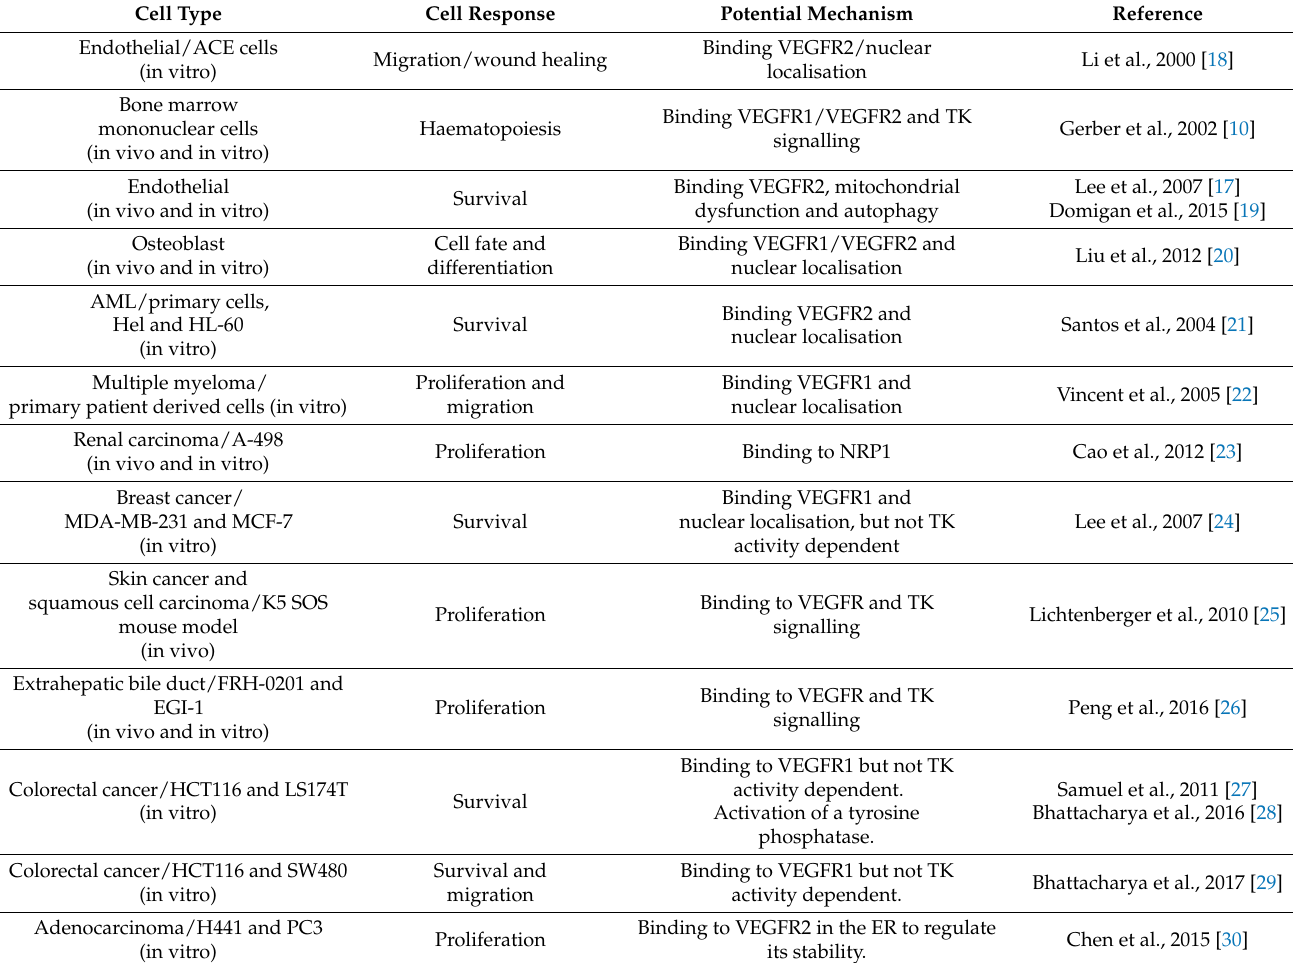
Figure 1. Different modes of Vascular endothelial growth factor A (VEGF-A) signalling. ( A ) VEGF-A characteristically signals through paracrine mechanisms. VEGF-A is synthesised with a secretion signal within signal sending cells and secreted into the extracellular matrix (ECM) as covalently linked homodimers. VEGF-A mediates many cellular responses on distant cells through interactions with several types of receptors including VEGFR1, VEGFR2, and also NRPs (not pictured). ( B ) After being secreted from cells, VEGF-A has also been shown to control many cellular responses through binding to receptors in an autocrine manner. ( C ) Emerging evidence suggests that VEGF-A can signal, without being secreted, in an intracrine manner. In different cell types and in different contexts this mode of signalling may proceed through interactions with receptors located within the cell, through relocalisation to the nucleus, or through mechanisms yet to be fully characterised. Table 1. Examples of VEGF-A acting in an intracrine